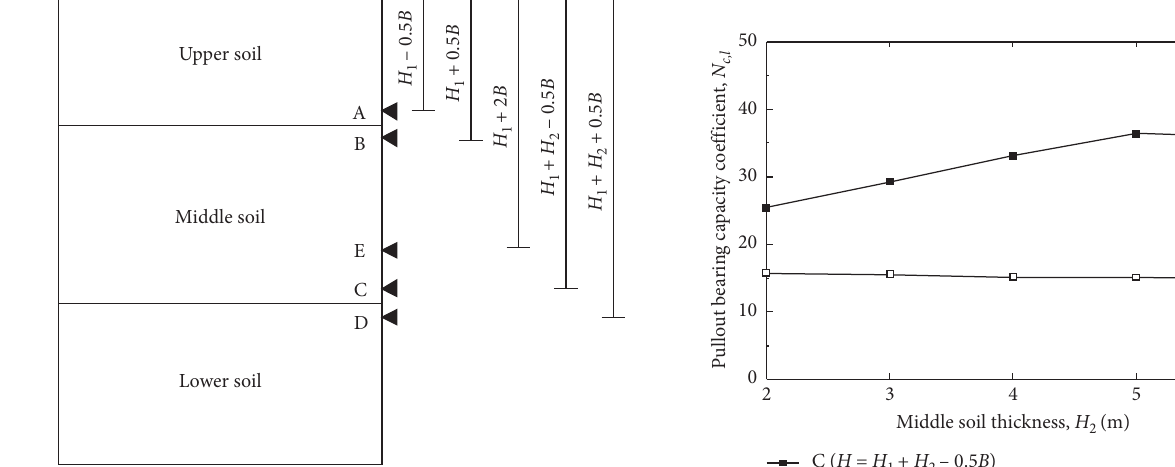
Figure 8: Diagram of the plate anchor buried at different positions.